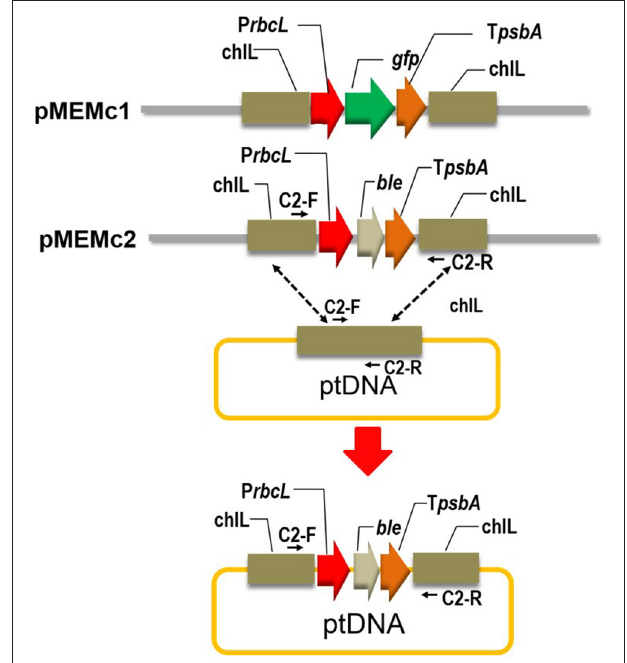
FIGURE 1 | Construct map of homologous recombinant vector in N. oceanica chloroplast. P rbcL , promoter of large subunit of RuBisCO gene ( rbcL ); T psbA , 3 ′ flanking sequence of gene encoding the D1 protein of Photosystem II ( psbA ); gfp , green florescence protein gene; chlL, light-independent protochlorophyllide reductase subunit; ble , zeosin resistance gene. Primers designed to examine the homoplasmic integration of the transforming cassette is indicated (c2-F and c2-R; Supplementary Table